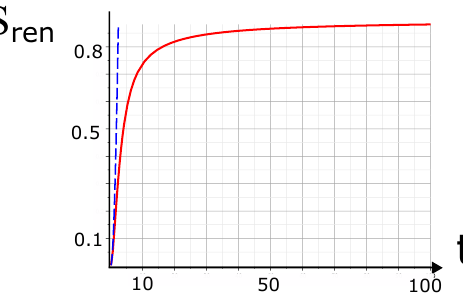
Figure 10 . Renormalized entanglement entropy (4.7) as a function of boundary time t for A = 1, p (cid:11) = 2 and c = 12. The dashed blue line represents the same quantity for the non-evaporating black hole, which after starting in the same way, diverges linearly for large t